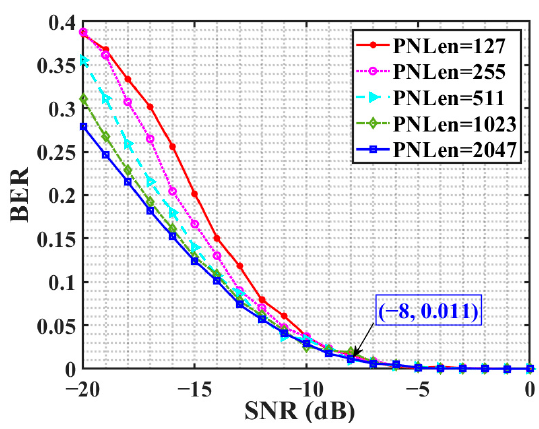
Figure 4. Variation curve of BER with SNR under different spreading code lengths.